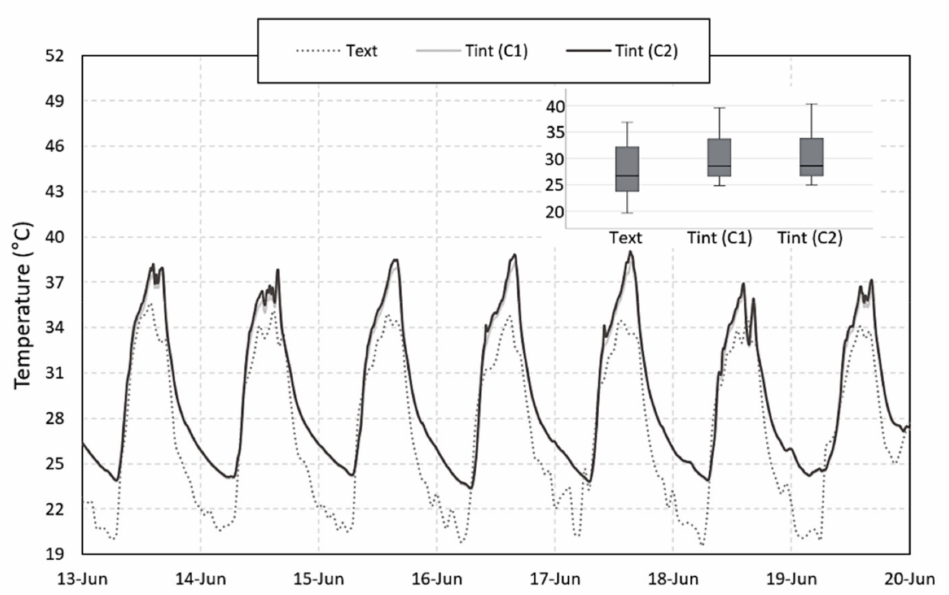
Figure 11. Variation of external and internal temperature in cells C1 and C2 during one week of campaign 1 (shading of the glazed